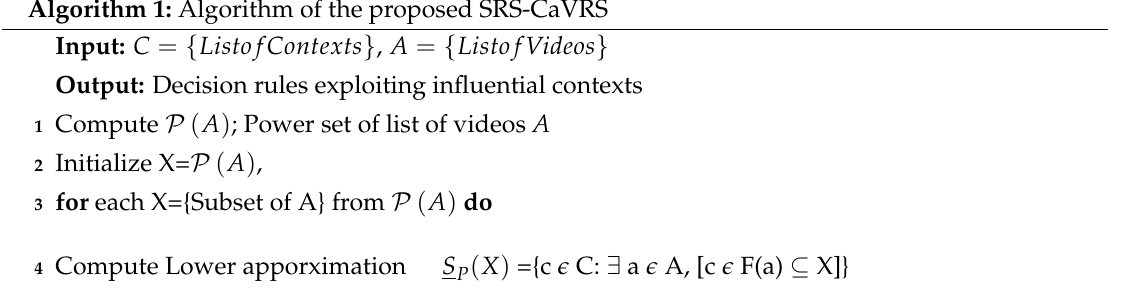
Algorithm 1: Algorithm of the proposed